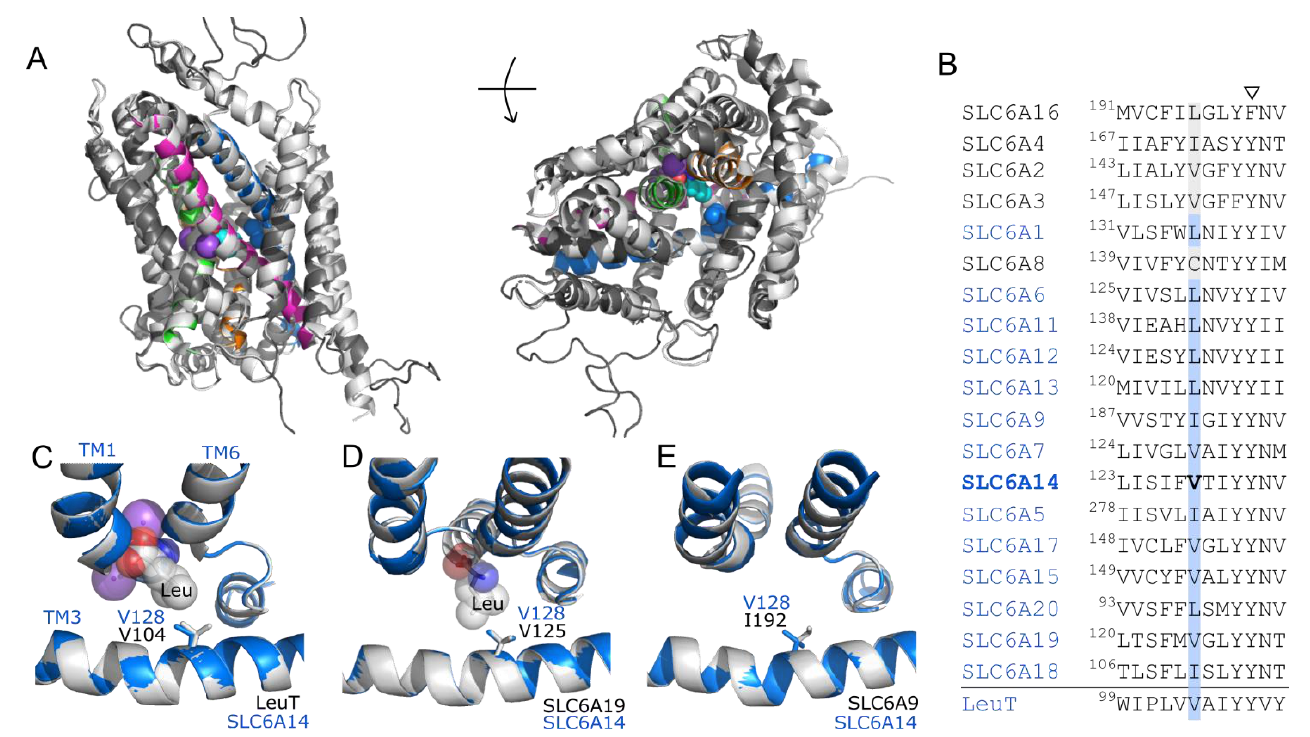
Figure 2. V128 occupies a key position, towards the bottom of the binding pocket, in the broad- spectrum amino acid transporter SLC6A14; the residue at this position varies within the SLC6 family. ( A ) Homology model of SLC6A14 (2.A.22.2.3, dark grey and coloured helices) superimposed on the prokaryote LeuT transporter (2.A.22.4.2) crystal structure (2A65, outward-occluded, leucine-bound, light grey helices) from which it was derived [50]. The key TM domains predicted to be involved in substrate binding in many LeuT fold structures are TM1 (green), TM3 (blue), TM6 (orange), TM8 (magenta). Spheres: residue V128 in TM3 of SLC6A14 (blue), leucine substrate (cyan), Na + ions (purple), both bound within the LeuT binding pocket. A section of the large extracellular loop between TM3 and TM4 is omitted. Left-hand image: protein “side on”, as it would reside in the membrane. Right-hand image: “top-down”, above the plane of the membrane, looking down into the binding pocket. ( B ) Alignment of the central section of TM3 in all human SLC6 proteins and the bacterial homologue LeuT. The pseudogenes SLC6A10P and SLC6A21 are excluded. Alignment was created with full-length protein sequences using MUSCLE. The residue equivalent to V104 in LeuT (V128 in SLC6A14) is highlighted in blue for amino acid transporting proteins and in grey for those which are not known to transport amino acids (i.e., the monoamine transporters and the or- phan transporter SLC6A16). Arrowhead indicates the highly conserved residue position equivalent to the gating residue Y163 in LeuT [50]. ( C – E ) Homology models of SLC6A14 (blue) created using LeuT (2A65, leucine-bound, outward occluded), human SLC6A19 (6M17, leucine-bound, outward- occluded) or human SLC6A9 (6ZBV, Cmpd1 inhibitor-bound, inward-open) crystal structures (grey), respectively. Only the central sections of TM3, TM1 and TM6 are shown. Sticks: V128 in each SLC6A14 model (blue) and equivalent residue in the resolved structure (grey). Spheres: leucine (grey/blue/red), Na + (purple) bound within the crystal structures of LeuT and SLC6A19. N.B. The large benzoylindoline inhibitor, Cmpd1, which locks SLC6A9 in an inward confirmation, has been omitted for clarity. Additional homology models are shown in Supplemental Figure S2.